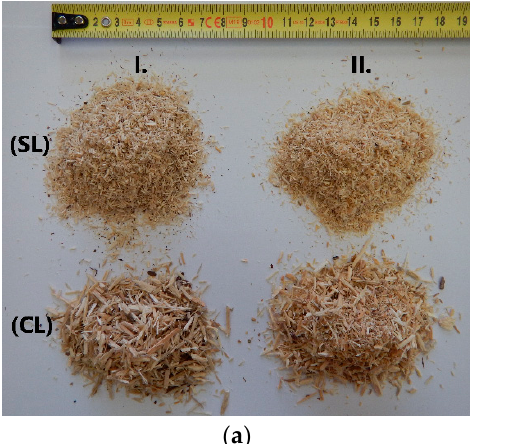
Figure 1. Views on the storage of discarded pallets in Kronospan s.r.o., Zvolen ( a ) , and on the determination of the modulus of elasticity (MOE d = density × /speed of ultrasonic waves in the longitudinal direction/ 2 ) of slab in pallet by the ultrasonic timer Fakopp ( b ).